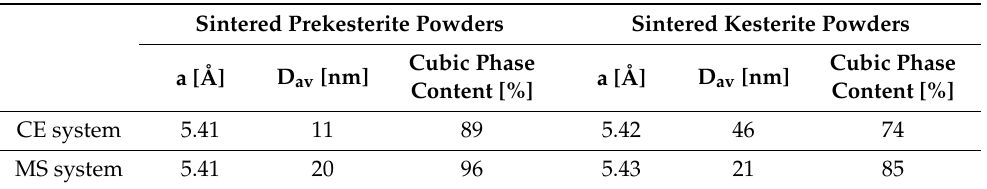
Table 3. Lattice constants a, average crystallite sizes D av , and the contents of the cubic phase present in the sintered pellets prepared from the nanopowders in the two precursor systems. Note that, in each case, cassiterite SnO 2 phase content adds up to 100% with cubic phase content.